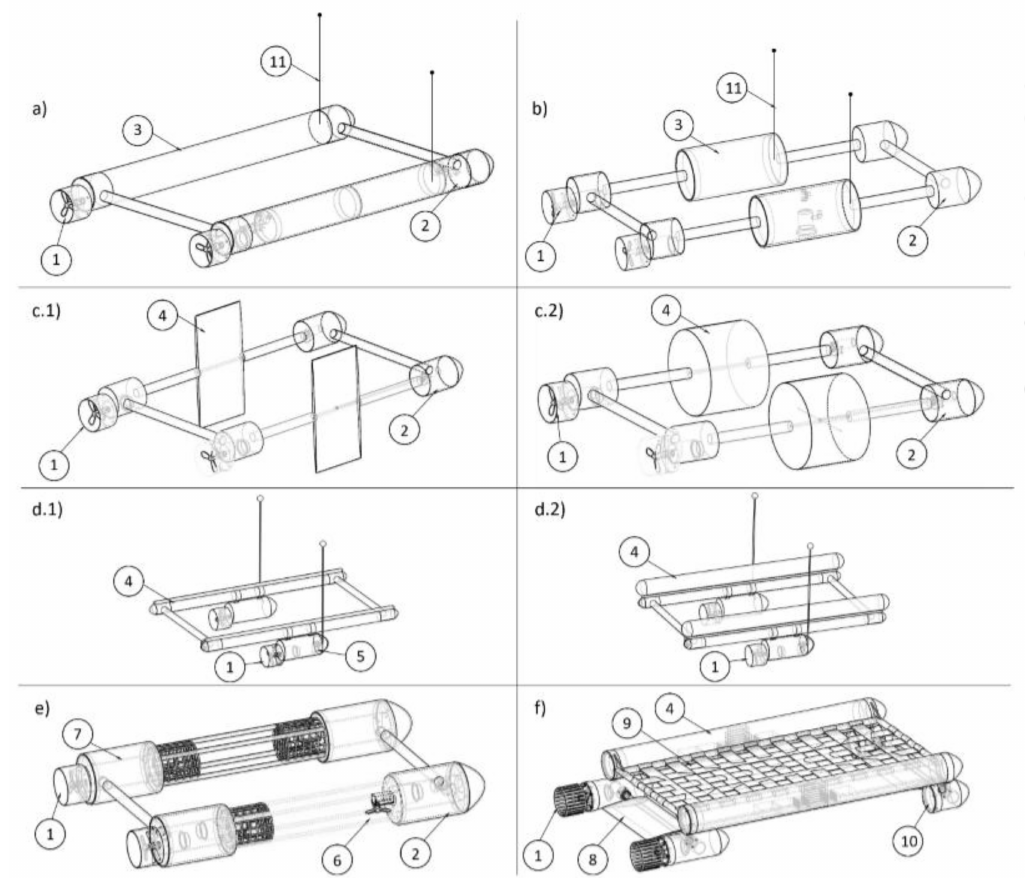
Figure 3. Configurations studied for the robot layout definition. ( a ) Static diving—vertical motion provided by filling and emptying four diving chambers of water. ( b ) Static diving—vertical motion provided by filling and emptying two diving chambers of water. ( c ) Static diving—deformable hulls ( c .1: flat hulls, c .2: inflated hulls). ( d ) Static diving—compressed air tanks ( d .1: flat dinghies, d.2: inflated dinghies). ( e ) Normal dynamic diving—vertical propellers. ( f ) Full dynamic diving—hydroplanes. 1: propeller. 2: electro-pump for static diving. 3: diving chamber. 4: deformable hull. 5: vacuum generator. 6: vertical propeller. 7: water tank. 8: hydroplane. 9: net. 10: electric motor for hydroplane actuation. 11: Snorkel.